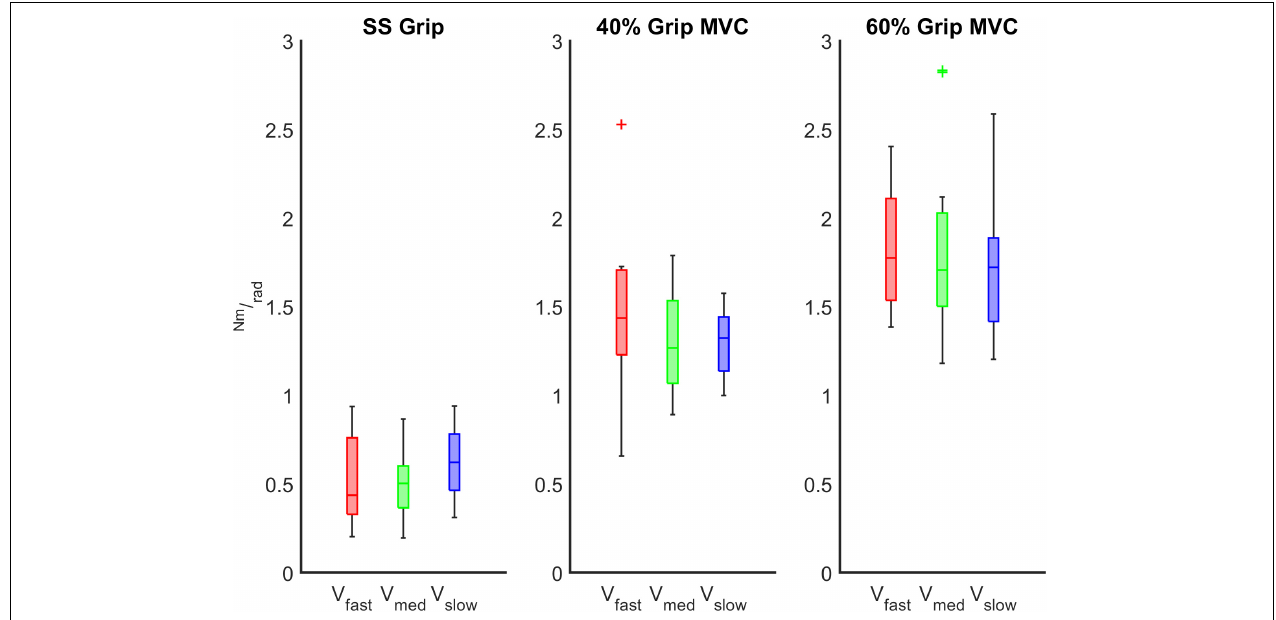
FIGURE 6 | K (Nm/rad) calculated across the different velocity conditions at the fixed grip conditions (SS Grip, 40% and 60% MVC Grip Force represented in the left, center and right subplots, respectively). These data belong to the RH group. The red, green, and blue boxplots identify the experimental conditions at fast, medium, and slow perturbations, respectively.